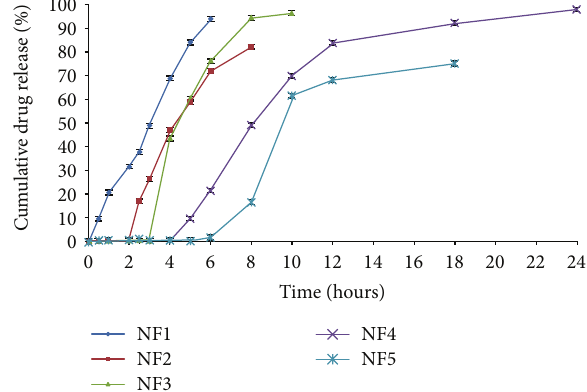
Figure 4: In vitro release profiles of naproxen sodium core tablets (NF1), press-coated HPC tablets (NF2), and press-coated HPC tabletsentericcoatedwithEudragitS-100indifferentconcentrations of 2.5%, 5.0%, and 7.5% (NF3, NF4, and NF5), respectively. Data are expressed as mean ± S.D. ( 𝑛 = 3 ).